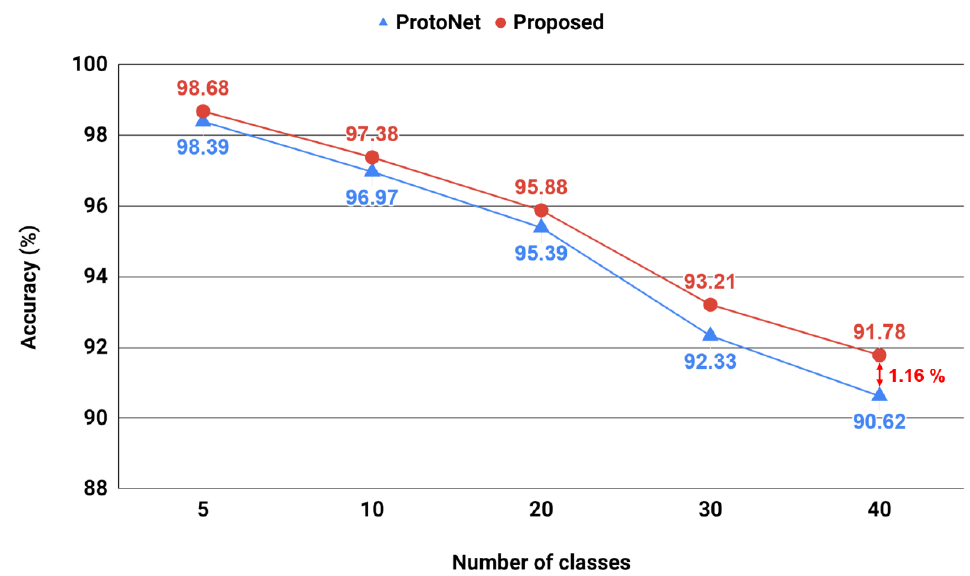
Figure 7. Change of Classification accuracy on Multi-PIE depending on the number of ways.